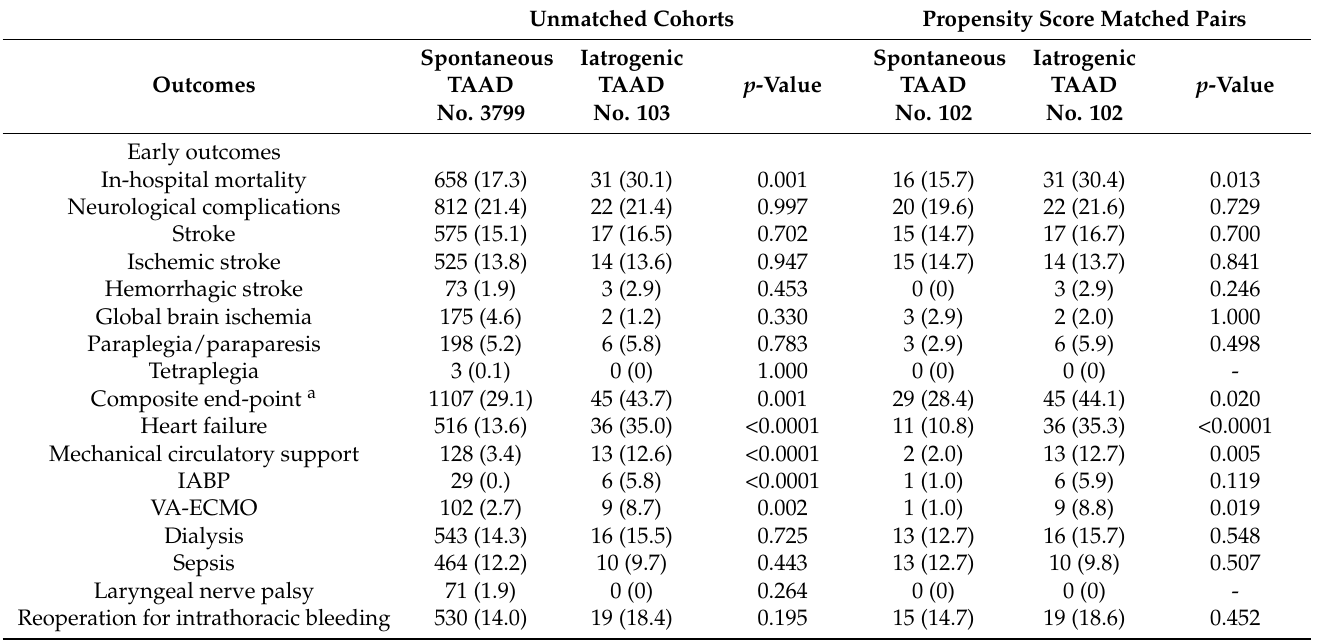
Figure 1. Survival estimates after surgery for acute type A spontaneous aortic dissection and iatro- genic aortic dissection secondary to cardiac surgery, percutaneous coronary intervention (PCI), coronary angiography, peripheral vascular intervention and transcatheter aortic valve replacement (TAVR). Table 4. Early and late outcomes of patients with spontaneous and iatrogenic acute TAAD in the unmatched and propensity score matched cohorts.